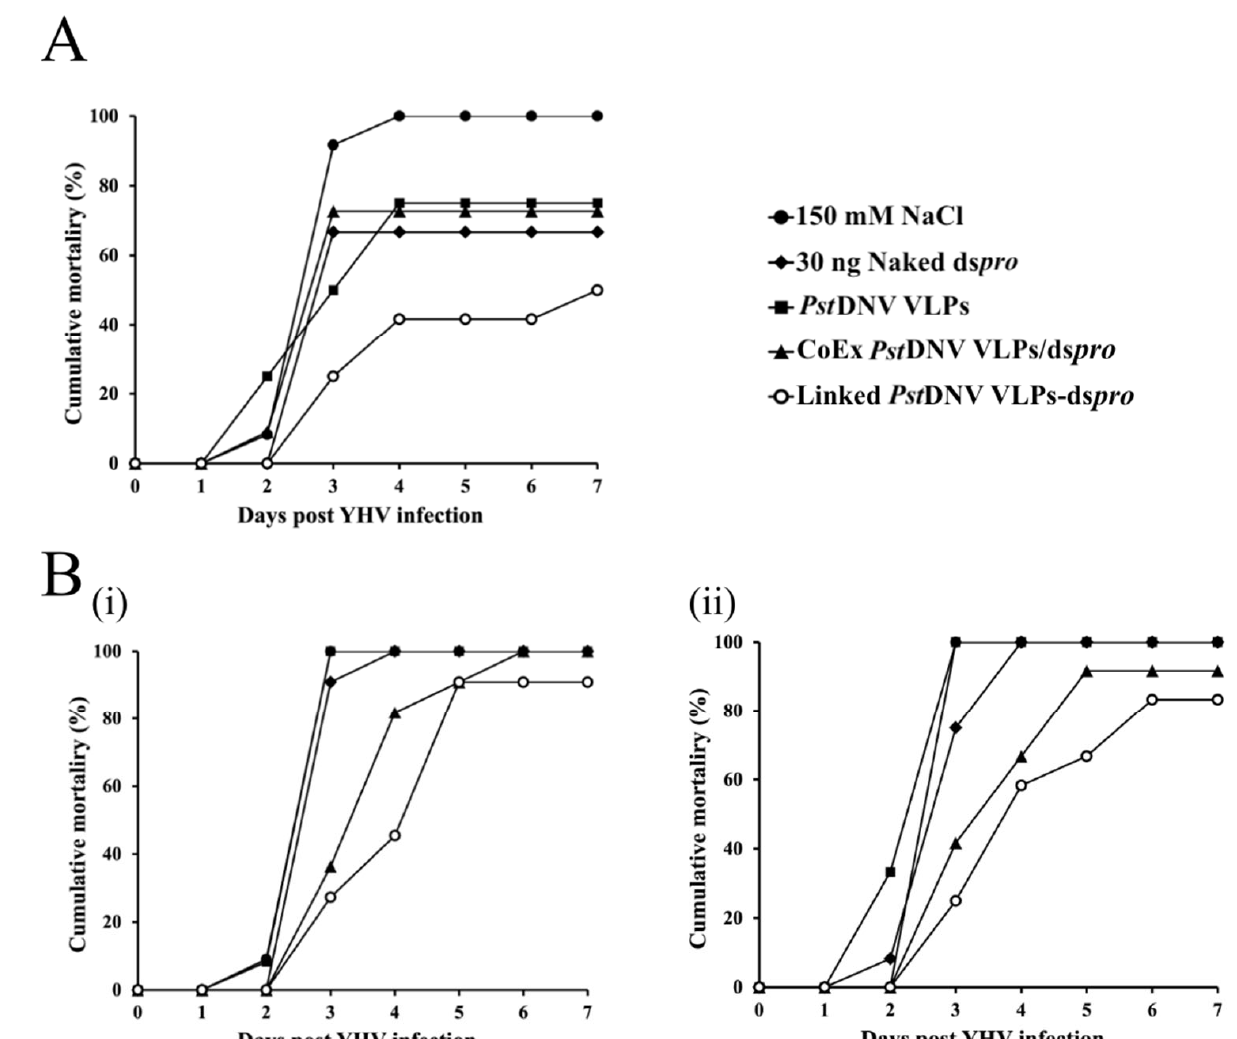
Figure 4. Inhibitory effect of Linked Pst DNV VLPs-ds pro against YHV infection in L. vannamei . Cu ‐ mulative mortality of shrimp (n = 10 − 13) treated with 150 mM NaCl, naked ds pro , Pst DNV VLPs,